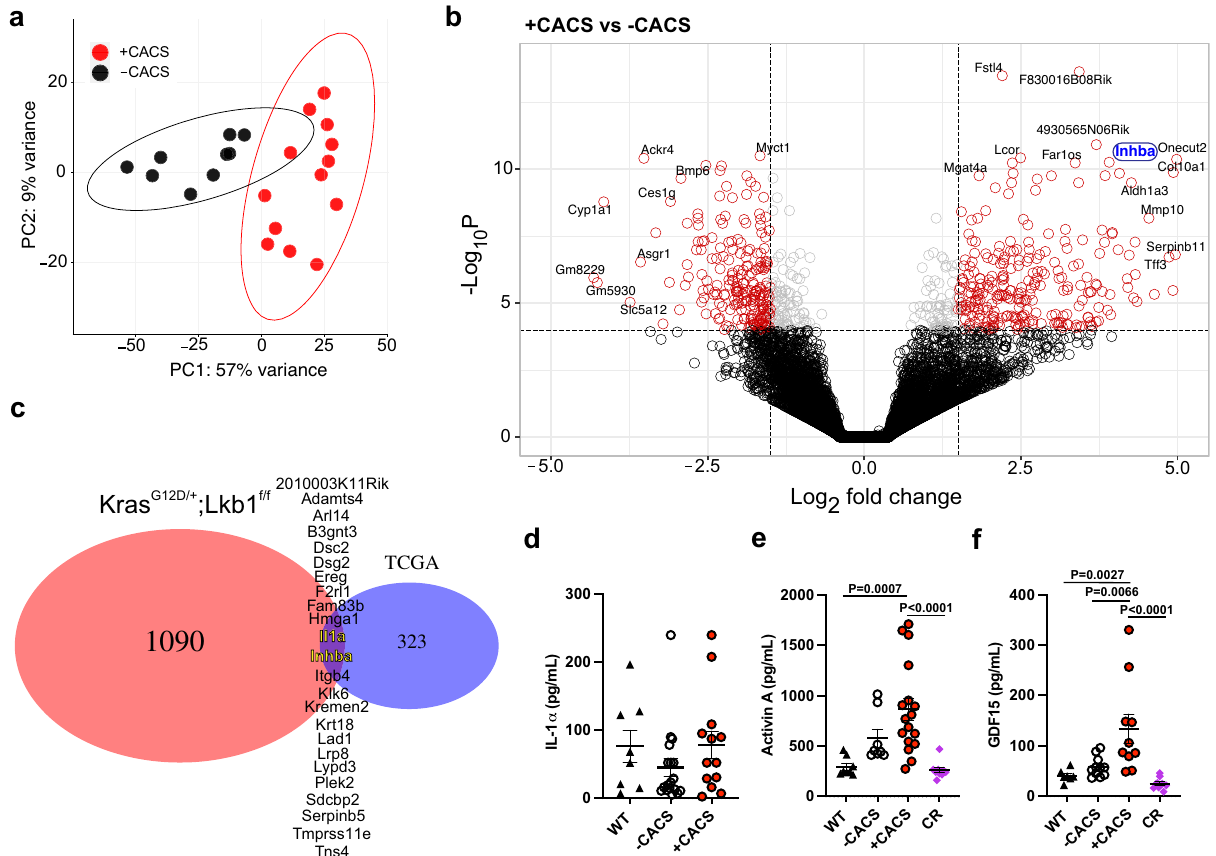
Fig. 4 | Tumors from mice with CACS have higher Activin A expression. a Principal Component Analysis (PCA) of RNA-Seq from tumors of -CACS ( n =9) and +CACS ( n =13) mice. b Volcano plot depicting INHBA as one of the most differentially expressed genes (DEG) in the RNA-Seq of tumors from +CACS mice compared to -CACS ( P <0.01 & Log 2 Fold Change >1.2). c Venn diagram between the DEG identi fi ed in b and the human genes associated with poor prognosis in lung cancer from TCGA. d IL-1 α levels in the serum of Fed ( n =8), -CACS ( n =10) and +CACS ( n =14) mice at the time of euthanasia. e Activin A levels in the serum